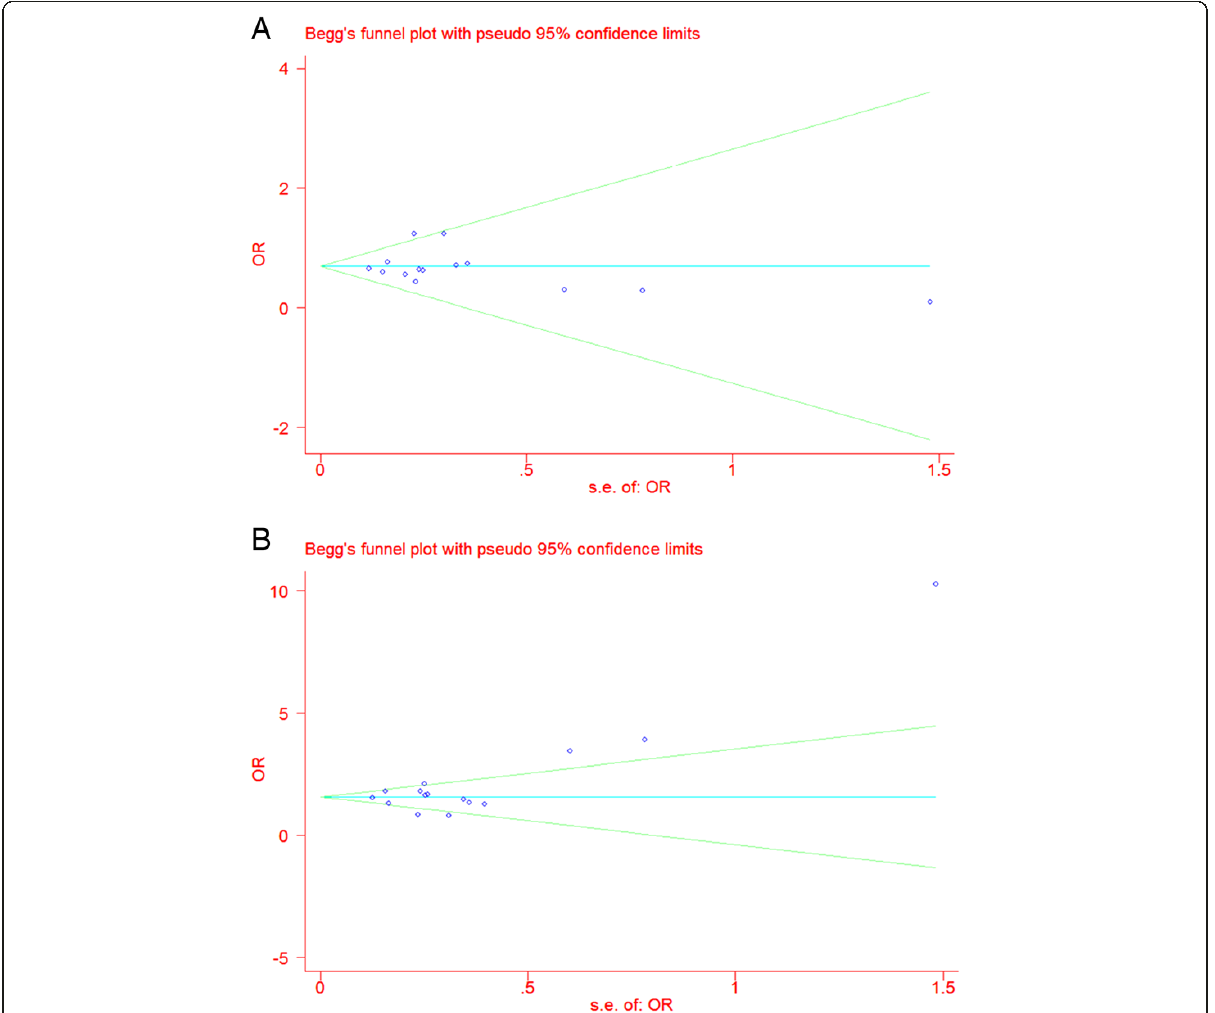
Figure 2 Funnel plot for rs7903146. Panel A : the ORs of allele T versus allele C of rs7903146 overall; Panel B : of the ORs of heterozygotes versus C homozygotes of rs7903146